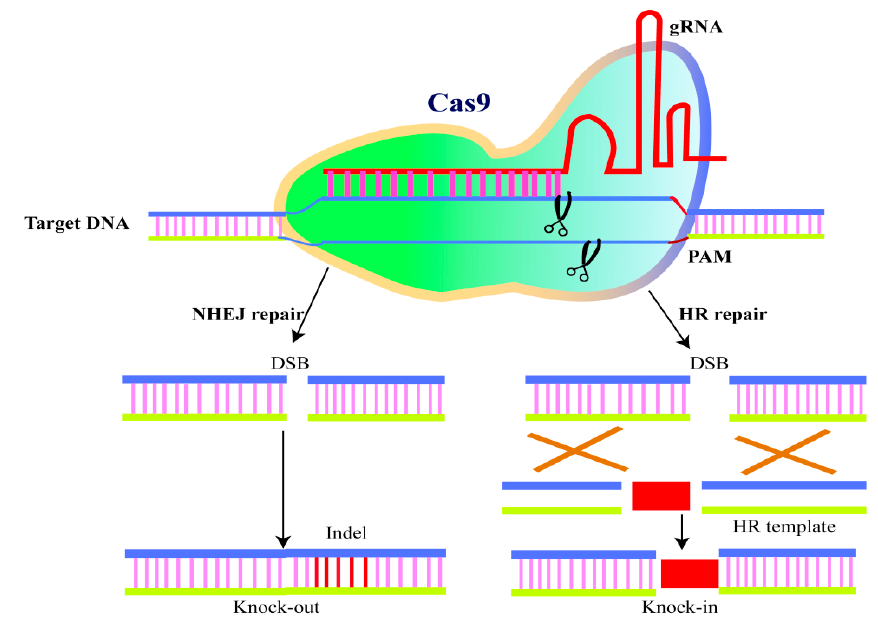
Figure 4. Schematic representation of Cas9/gRNA genome editing. CRISPR/Cas9 system consists of sgRNA and Cas9 nuclease. The sgRNA directs the sequence-specific Cas9 nuclease to start double-strand DNA breaks in the target DNA. The cell’s DNA repair machinery, comprising HR and NHEJ pathways, repairs the strand breaks, creating a short deletion/insertion (gene knockout), new sequence insertion and/or sequence modification. sgRNA, single guide RNA; HR, homologous recombination; NHEJ, non-homologous end joining (adopted and modified from [236]).